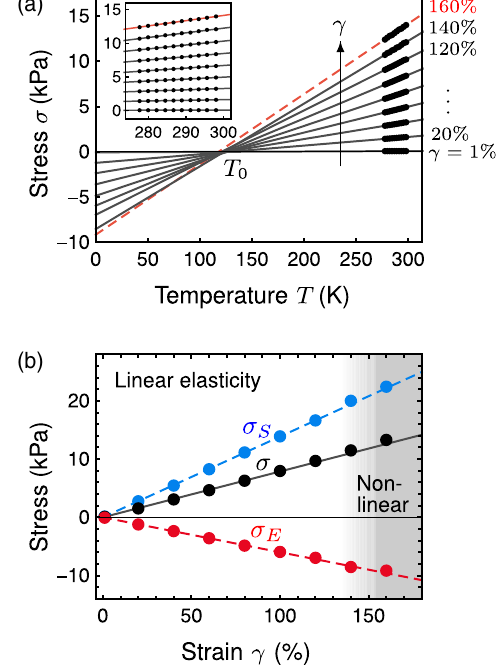
FIG. 4. Polymer gel exhibiting a wide range of linear elasticity under shear deformation. (a) Temperature ( T ) dependence of (shear) stress σ under fixed (shear) strain γ (1%, 20%, 40%, 60%, 80%, 100%, 120%, 140%, 160%, and 180%) within 278 K ≤ T ≤ 298 K. The data for γ ¼ 60% correspond to Fig. 1(b). The straight lines are obtained from the least-squares fit and extrapo- lated to T ¼ 0 K. Within the measured range, σ is a nearly linear function of T at each γ (inset). The gray solid extrapolation lines ( γ ≤ 140% ) pass through the vanishing temperature T 0 on the T axis. (b) Stress ( σ ) – strain ( γ ) curve (black symbols) with σ (blue S symbols) and σ (red symbols). The data are extracted from (a) at E T ¼ 288 K. The σ , σ , and σ show linear elasticity over a wide S E range up to γ ¼ 140% . The linearity of σ and σ to γ S E corresponds to the γ independence of T 0